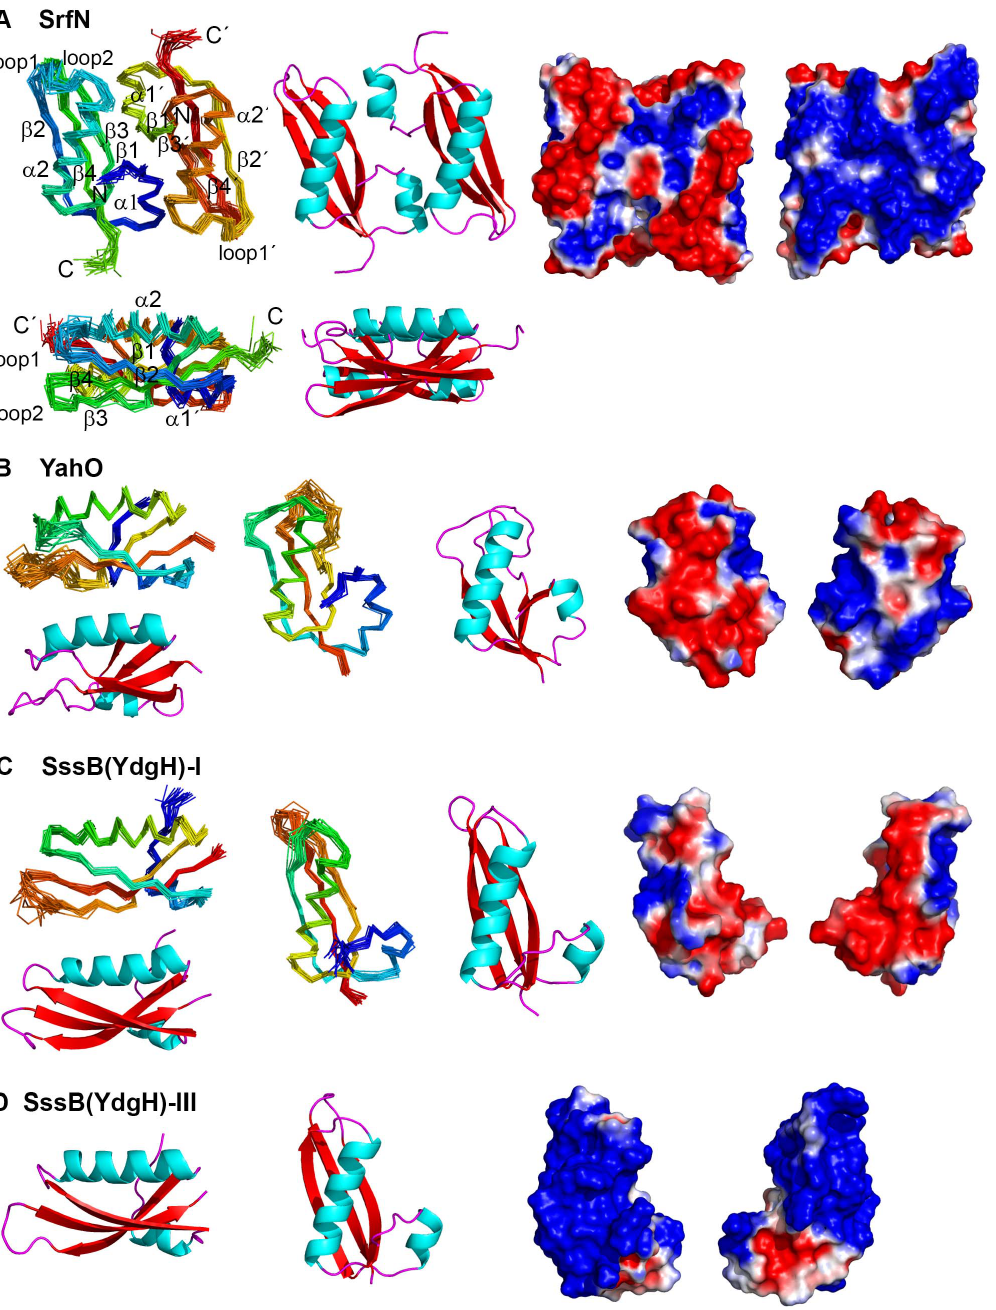
Figure 2. Structures and surface electrostatic characteristics of DUF1471 proteins. A : SrfN (dimer), B : YahO, C : SssB-I, D : SssB-III. In addition to ribbon cartoons colored by secondary structure, NMR structures show 20-member ensembles as C a traces superimposed over the ordered residues determined by PSVS [51]. Electrostatic surface calculations were calculated with APBS using the PyMol plugin, with default parameters (0.15 M salt, kT/e= 2 1 to 1, pH 7.0) for the first members of the SrfN, SssB-I, and YahO ensembles and for SssB-III after conversion with PDB2PQR. The van der Waals surfaces are shown and are colored according to the charge (red for negative, blue for positive) on the water-accessible surface. Hydrogen atoms were added to SssB-III. The C-terminal 6x-His tags were removed and replaced with carboxylates for the calculation. N-termini for SrfN and YahO did not have the cleaved signal sequence, the N-terminus of SssB-III began at residue Lys 247. doi:10.1371/journal.pone.0101787.g002 that appear to be involved in a network of intra- and inter- approximately midway between the values measured for dimeric molecular hydrogen bonds and ion pairs. Such an interface could SrfN in low salt and monomeric YahO and SssB-III, indicating conceivably be disrupted by high salt concentrations. Indeed, a that the dimeric species may be partially disrupted. The existence sample of 15 N-labeled SrfN in pH 5.5 ammonium acetate buffer of different oligomerization states among paralogous proteins is not uncommon, and dimerization in SrfN may be a property with 0.5 M NaCl yielded an estimated t c (at 25 u C) of 9 ns,